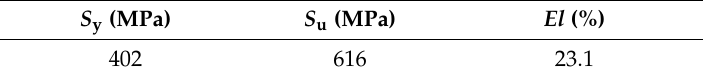
Table 2. Tensile test results for DP600 steel.